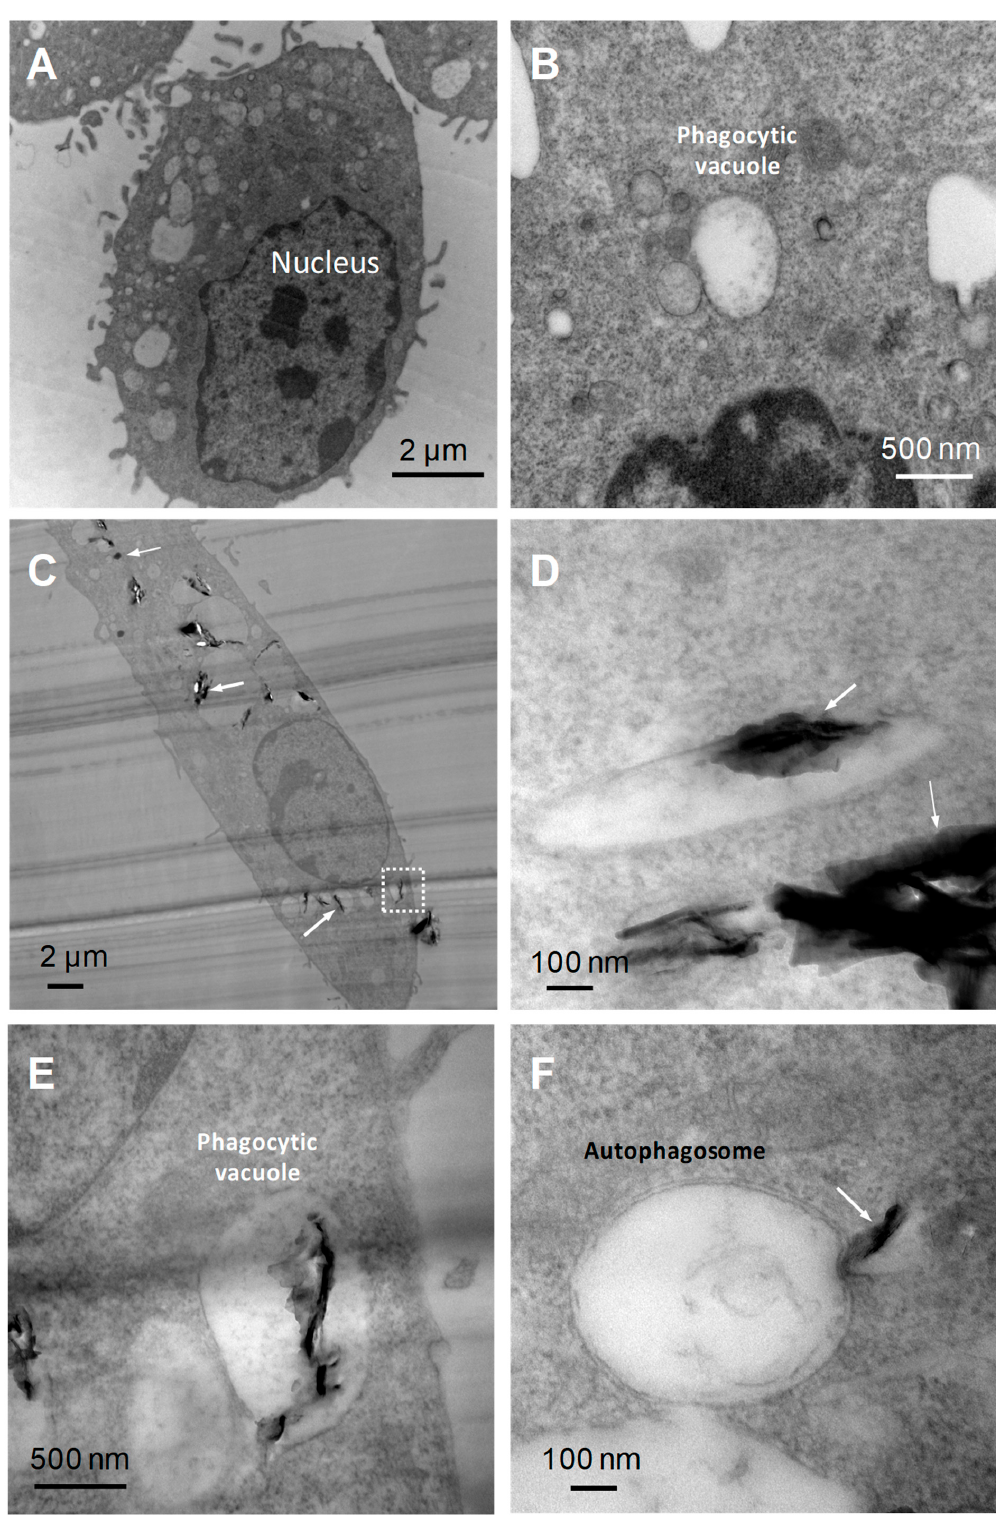
Figure 1. TEM images of BMDMs (bone marrow-derived macrophages). ( A ) Untreated BMDMs. ( B ) Magnified image of a phagocytic vacuole in untreated BMDMs. ( C ) BMDMs after 24 h incubation with high-dose FLG (few-layer graphene) (100 µ g / mL) showing the nucleus and FLG internalized within the vacuoles and in the cytoplasm. ( D ) Magnified image of FLG into a phagocytic vacuole and into the cytoplasm. ( E ) Magnified image of phagocytic vacuole (white dotted box in panel ( C ) showing internalized FLG in a vacuole. ( F ) Double-membrane autophagosome with FLG in process of